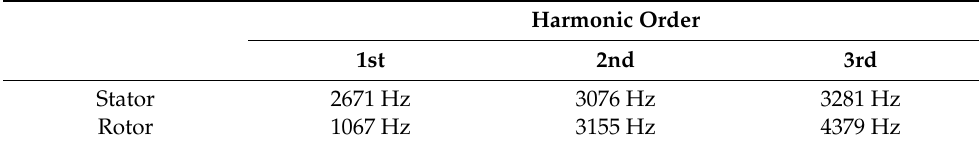
Table 2. Natural frequency analysis results for the stator and rotor considering assembly.